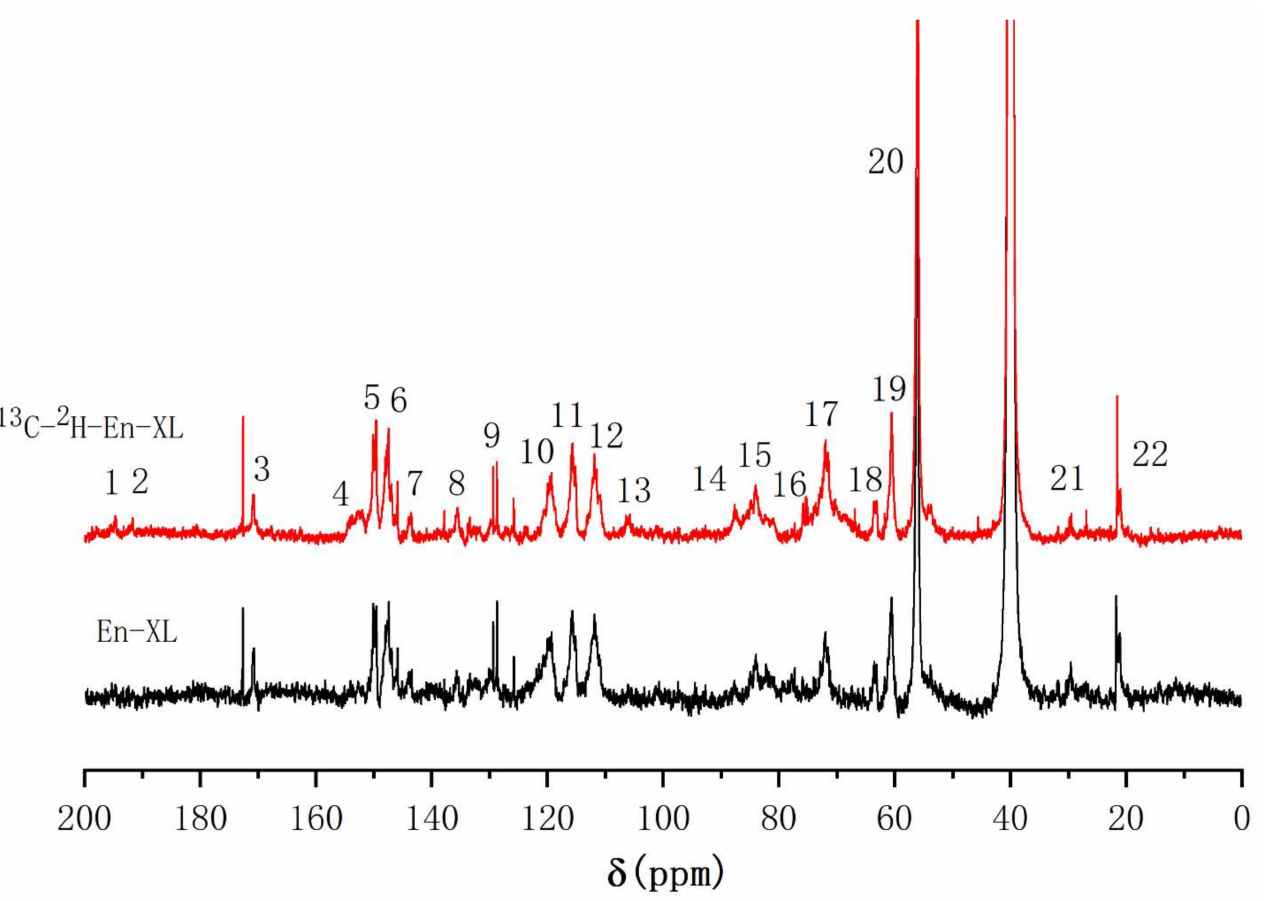
Figure 8. 13 C-NMR spectra of En-XL from ginkgo